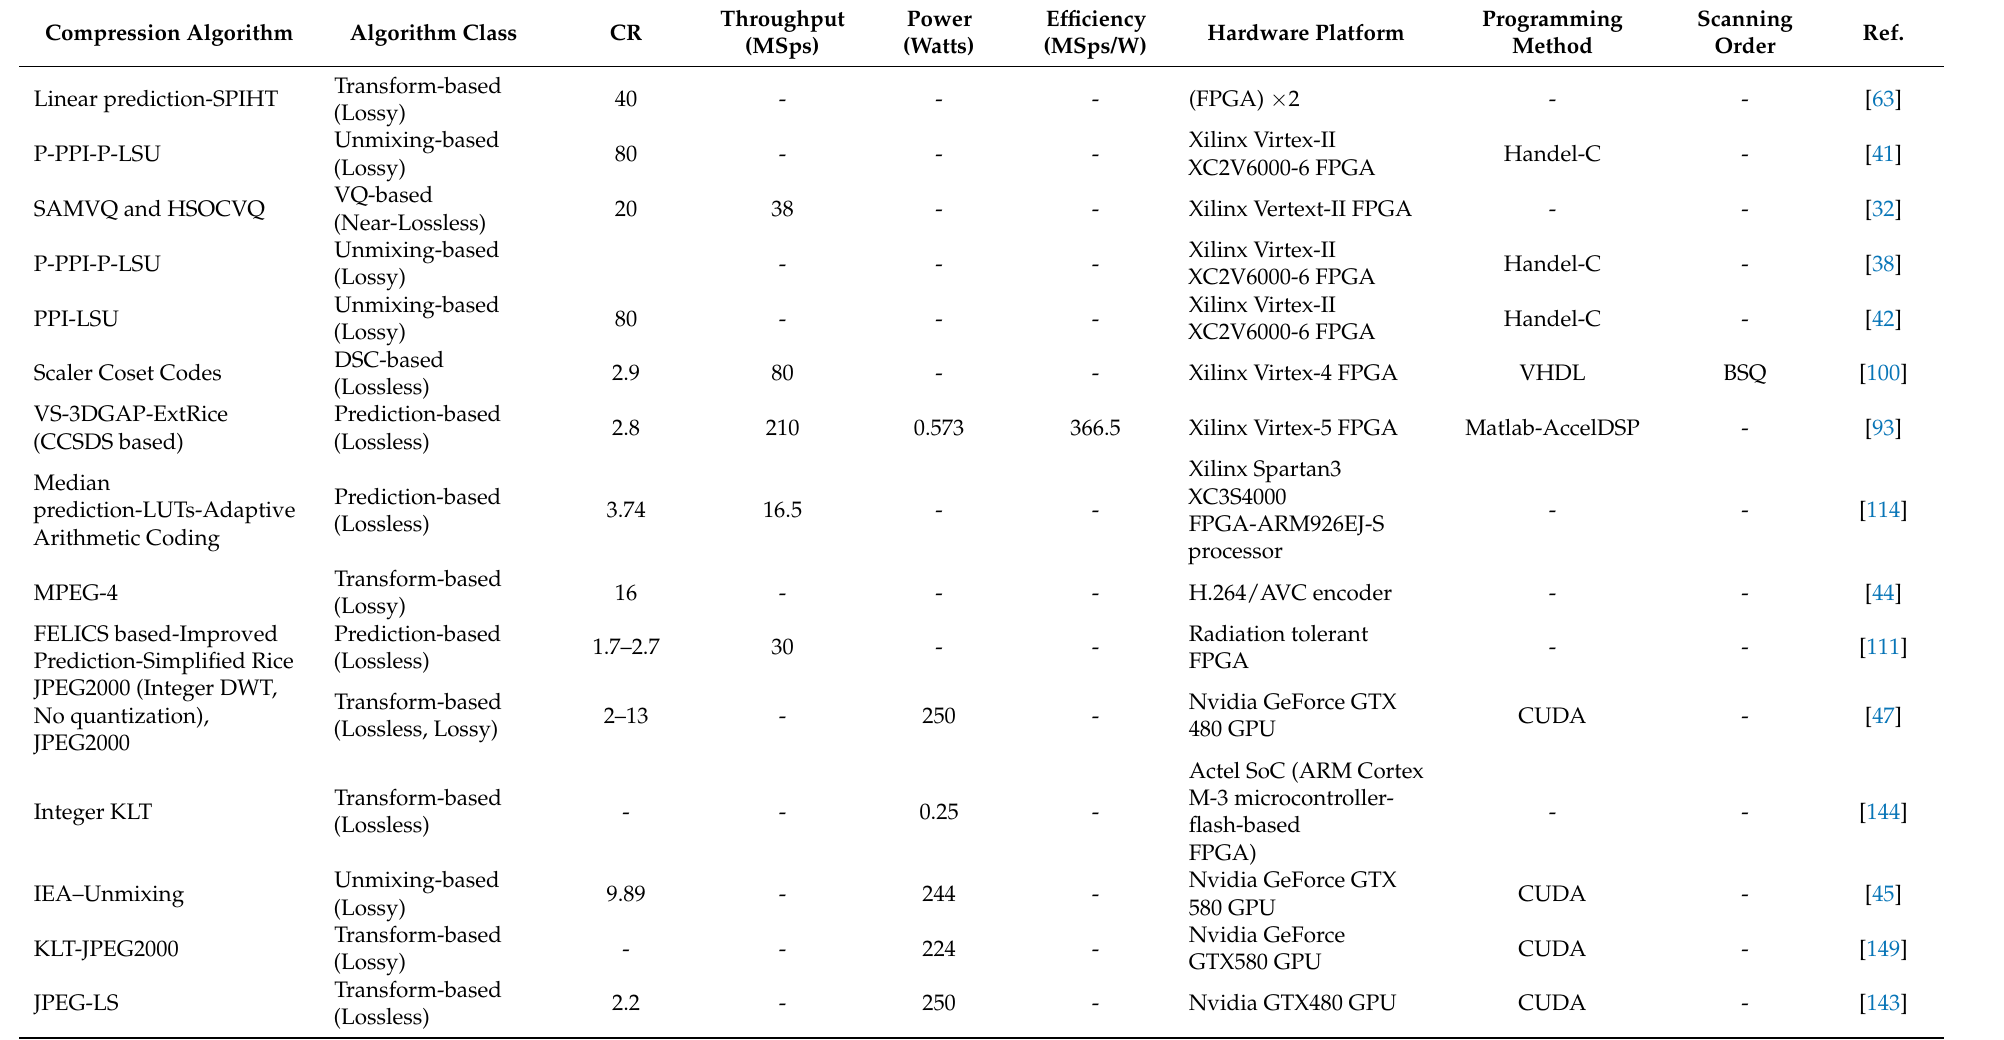
Table 10. Comparison of the proposed compression system validated using the AVIRIS Cuprite